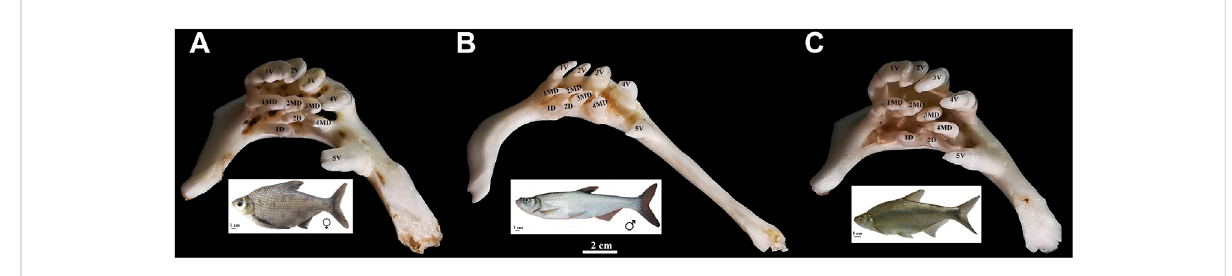
FIGURE 1 Appearance of pharyngeal teeth in BSB (A) , TC (B) , and BT (C) . Five ventral teeth (positions 1 – 5V), four mediodorsal teeth (1 – 4MD), and two dorsal teeth (1D and 2D) in each pharyngeal teeth is shown; bar = 2 cm. The appearance of BSB, TC, and BT are below each of the pharyngeal teeth; bar = 1